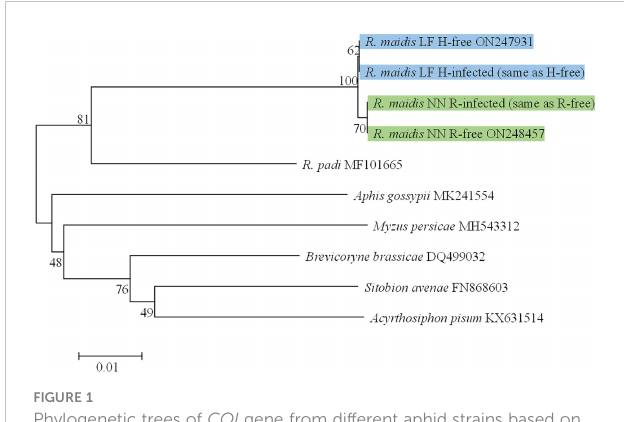
FIGURE 1 Phylogenetic trees of COI gene from different aphid strains based on neighbor-joining (NJ) method. Green frames, aphid strains from Nanning City. Blue frames, aphid strains from Langfang City.